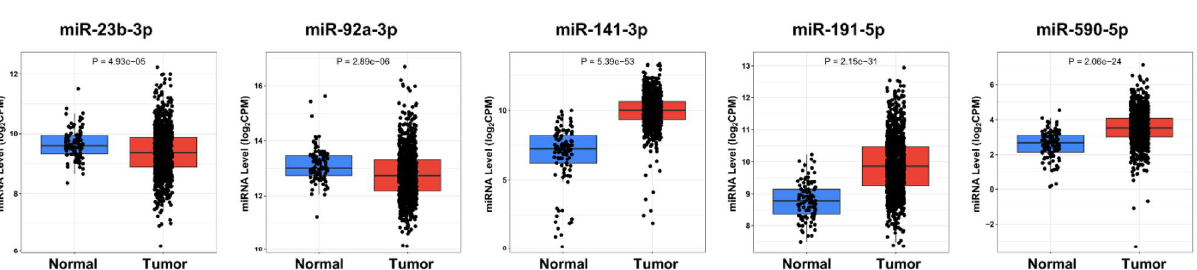
Figure 11. Expression level of the 5 miRNA biomarkers in the diagnostic models in TCGA normal (n = 104) and BC tumor (n = 1078) using CancerMIRNome